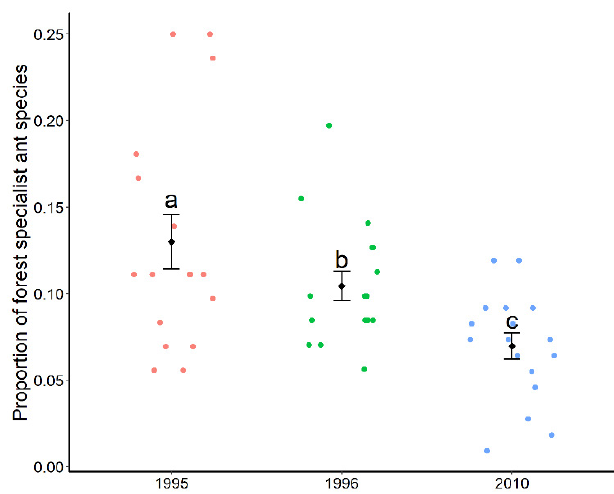
Fig 5. Average proportion of forest specialist ant species richness across studied fragments, located in southeastern Brazilian Atlantic rain forest. In 1995 it was higher when compared to 1996 and 2010 in fragments located in southeastern Brazilian Atlantic rain forest (p < 0.001). Points represent the proportion of forest specialist ant species from each fragment sampled in each year. The black lozenges represent the average and the bars represent the standard error. Different letters represent significant differences at alfa =